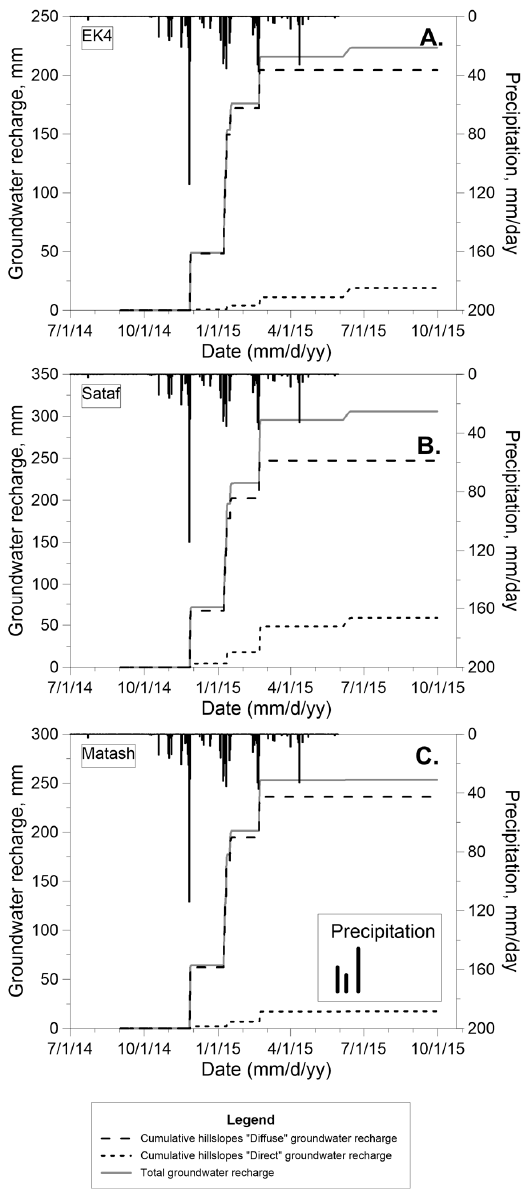
Figure 5. Cumulative groundwater recharge in ( A ) EK4; ( B ) Sataf; and ( C ) Matash sub-basins.